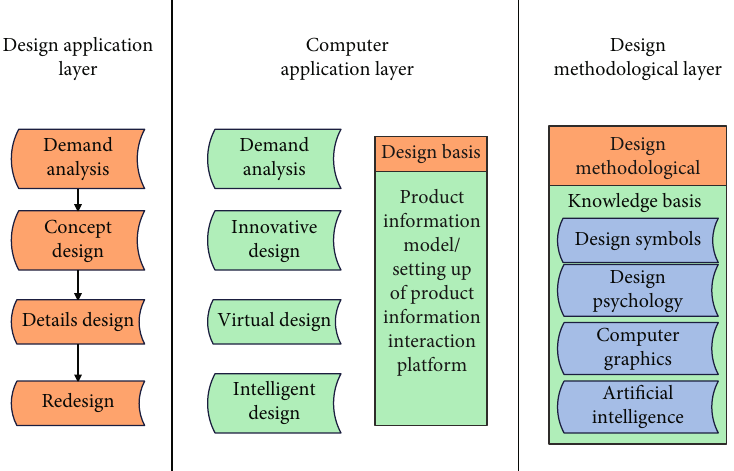
Figure 10: Overall frame diagram of computer-aided industrial design.